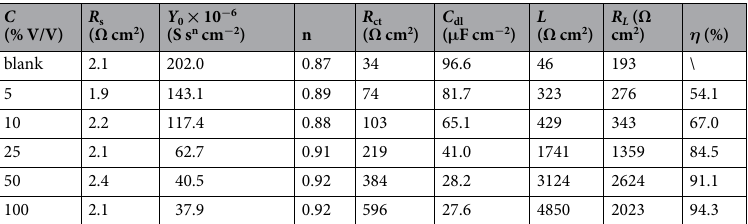
Table 2. The EIS parameters for mild steel in 0.5 mol/L H 2 SO 4 solution without and with different V/V concentrations of LLE at 298